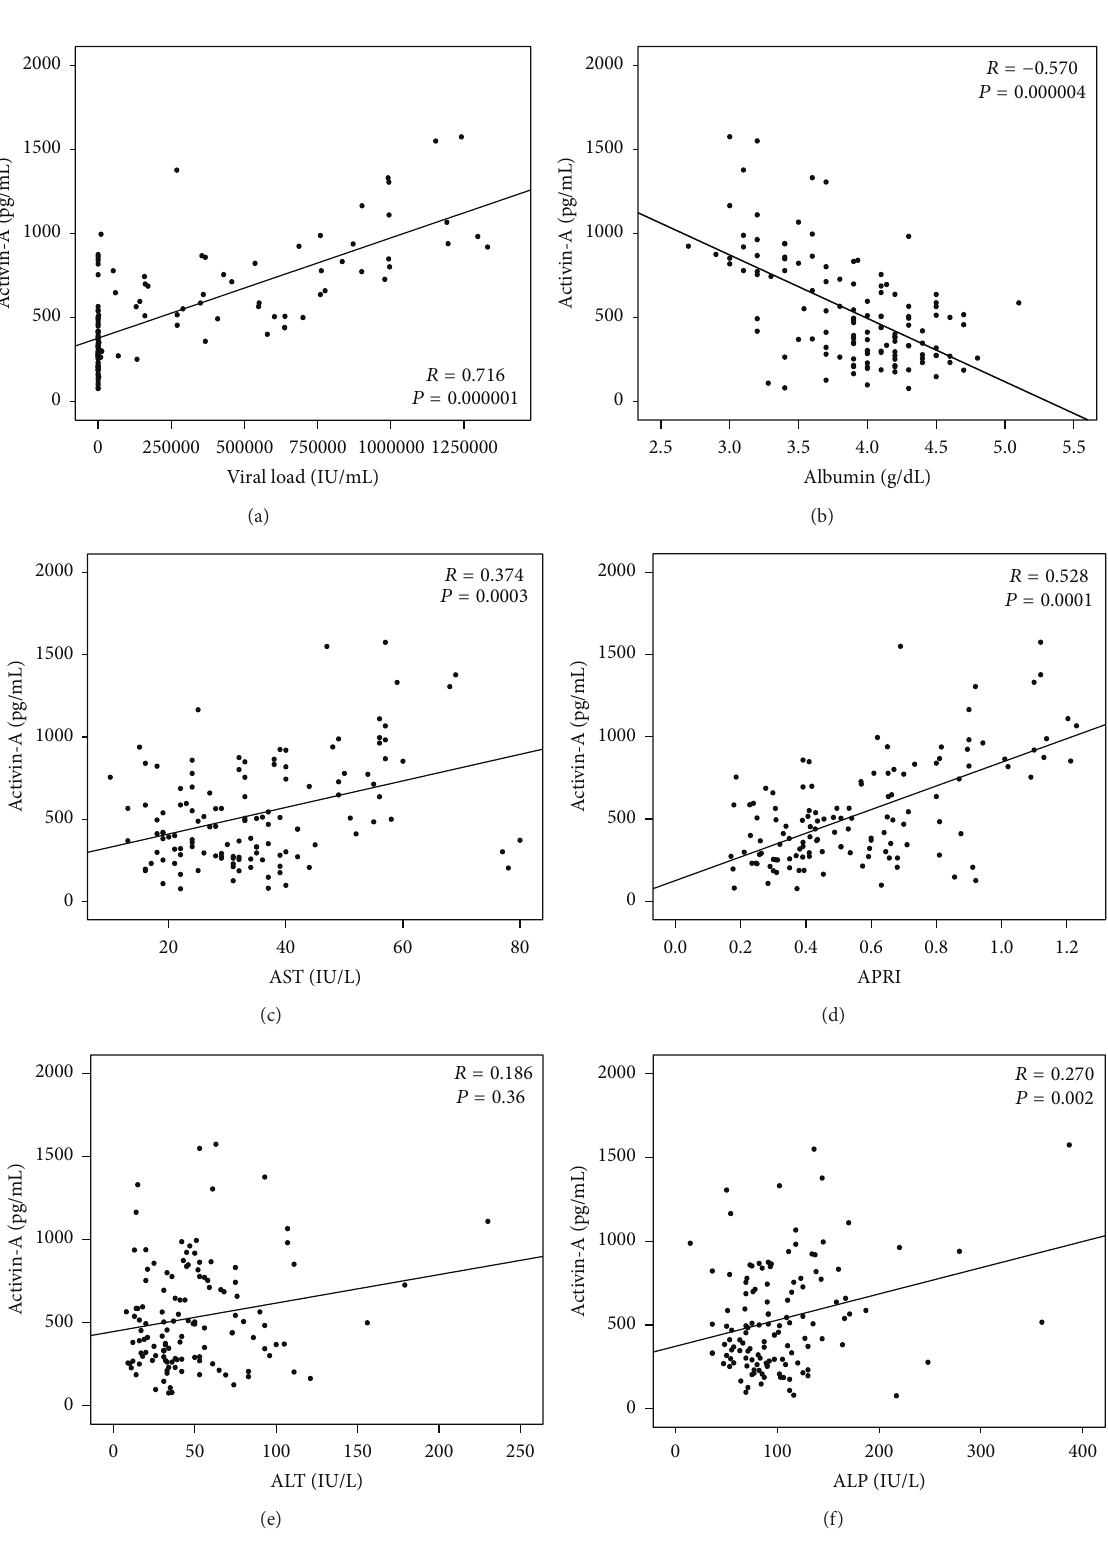
Figure 2: Correlation of serum activin-A with (a) viral load, (b) serum albumin, (c) AST, (d) APRI, (e) ALT, and (f) ALP by Pearson’s correlation